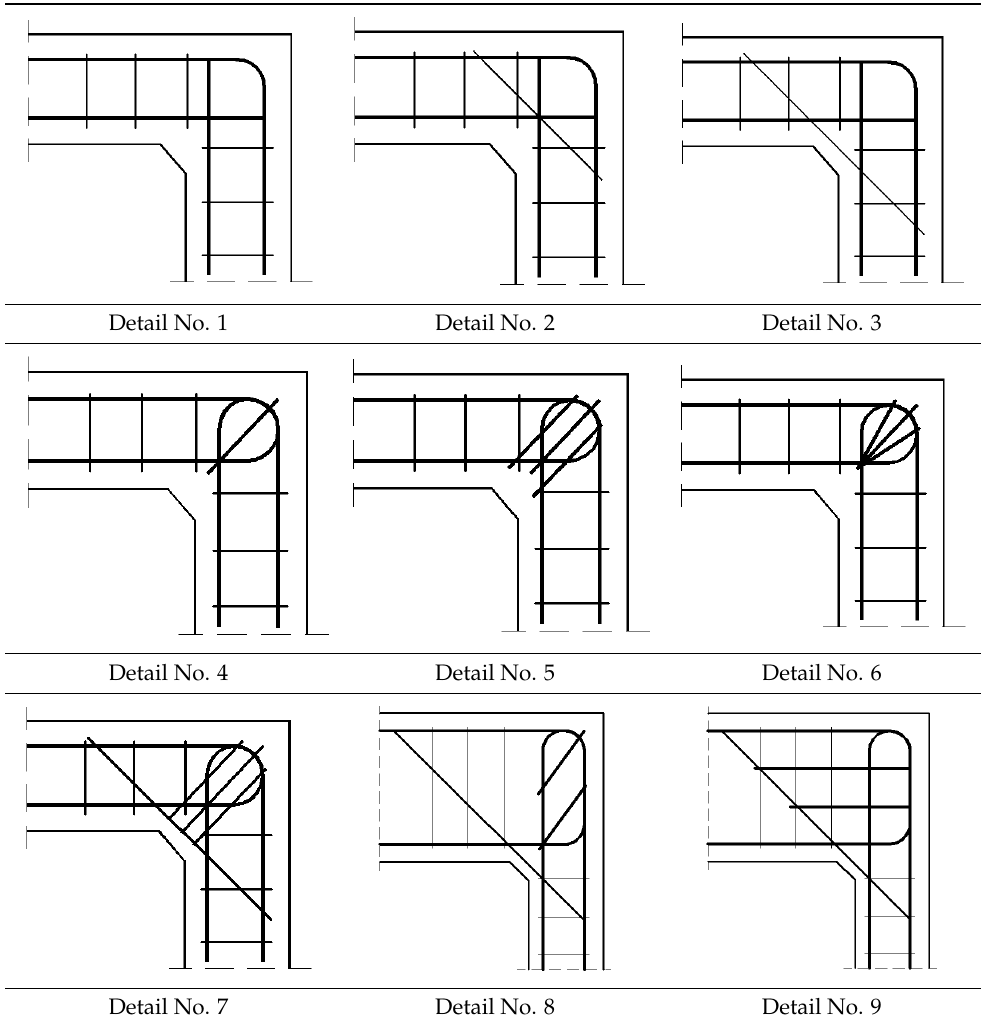
Table 2. Reinforcement details analyzed in the research.